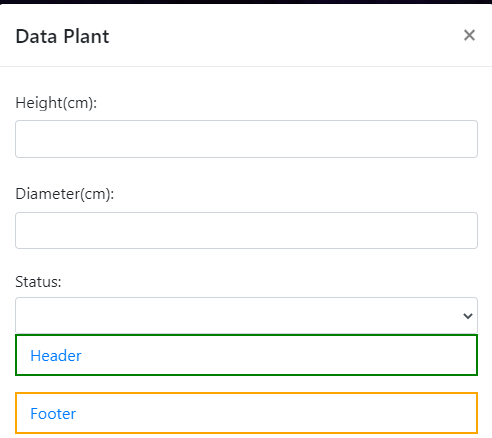
Figure 4. Height and diameter manual sampling interface.